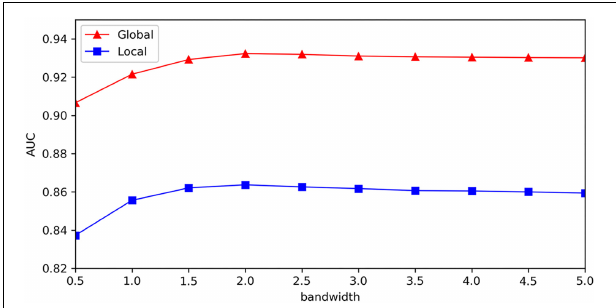
FIGURE 6 | Sensitivity analysis for bandwidth of Gaussian kernel.